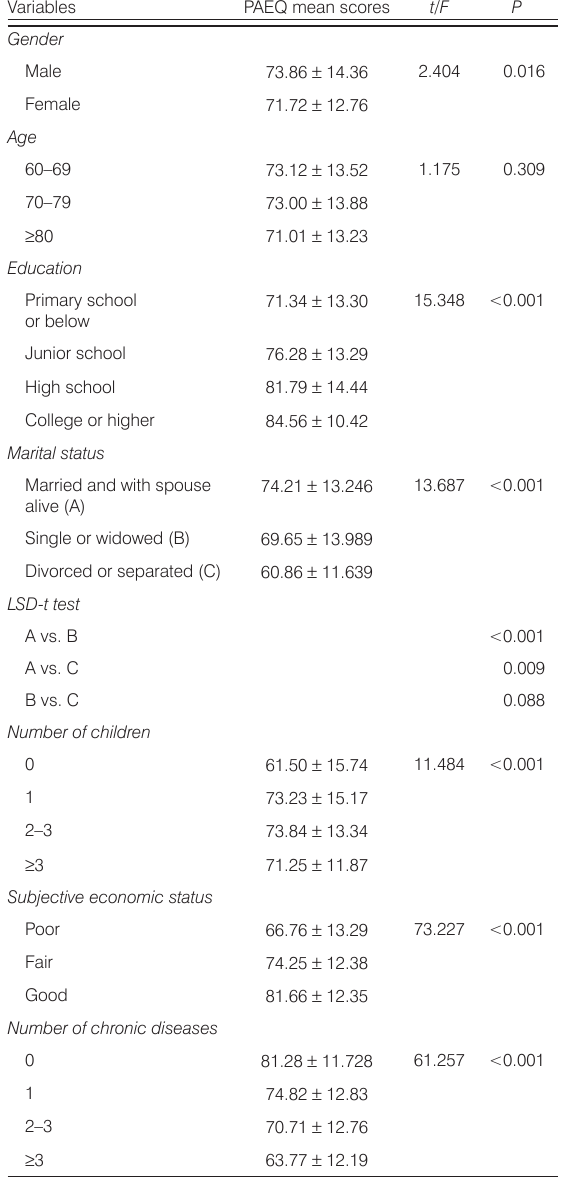
Table 4 Mean scores of dimensions of PAEQ and comparison ( N = 935).